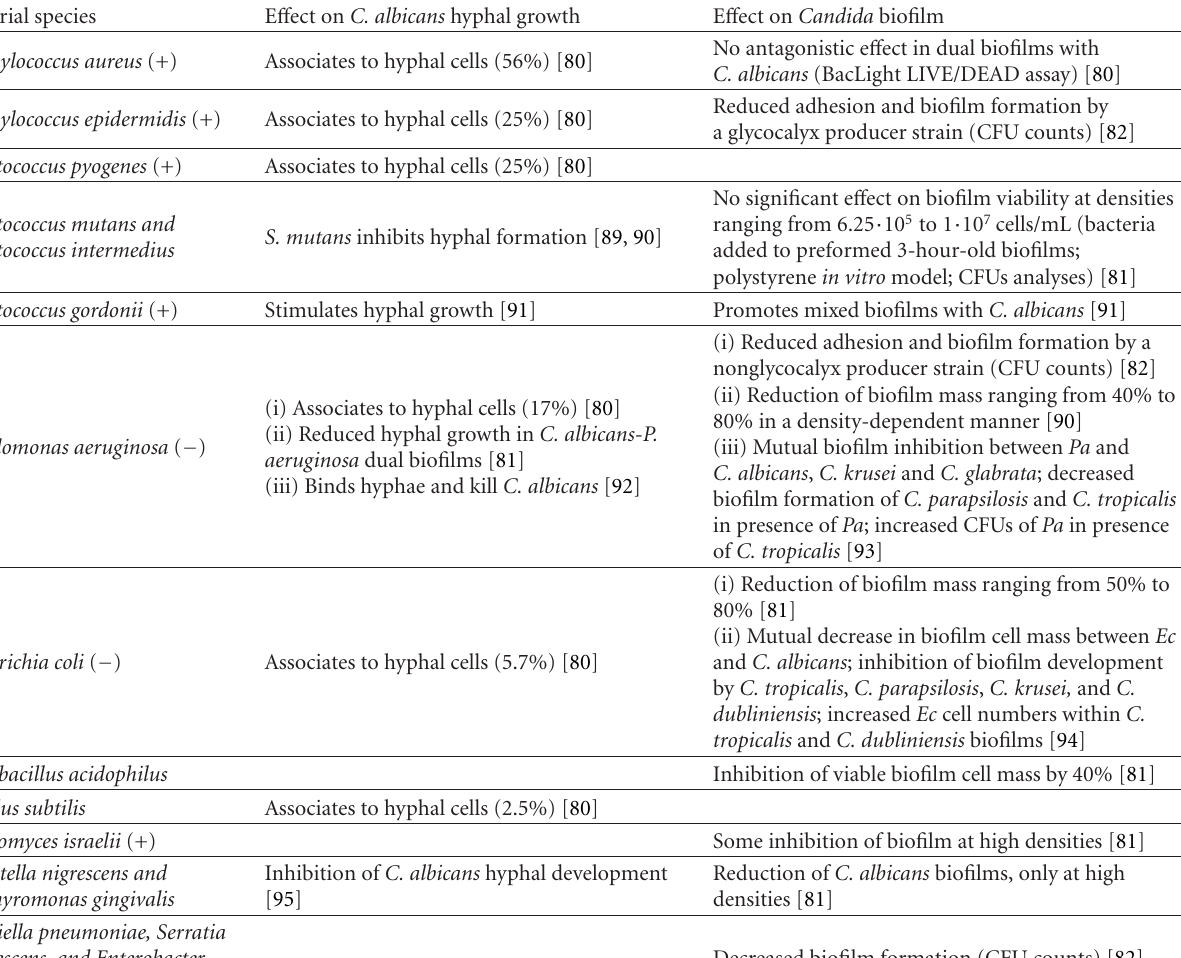
Table 3: Interspecies relationship with Candida spp. growth and biofilm